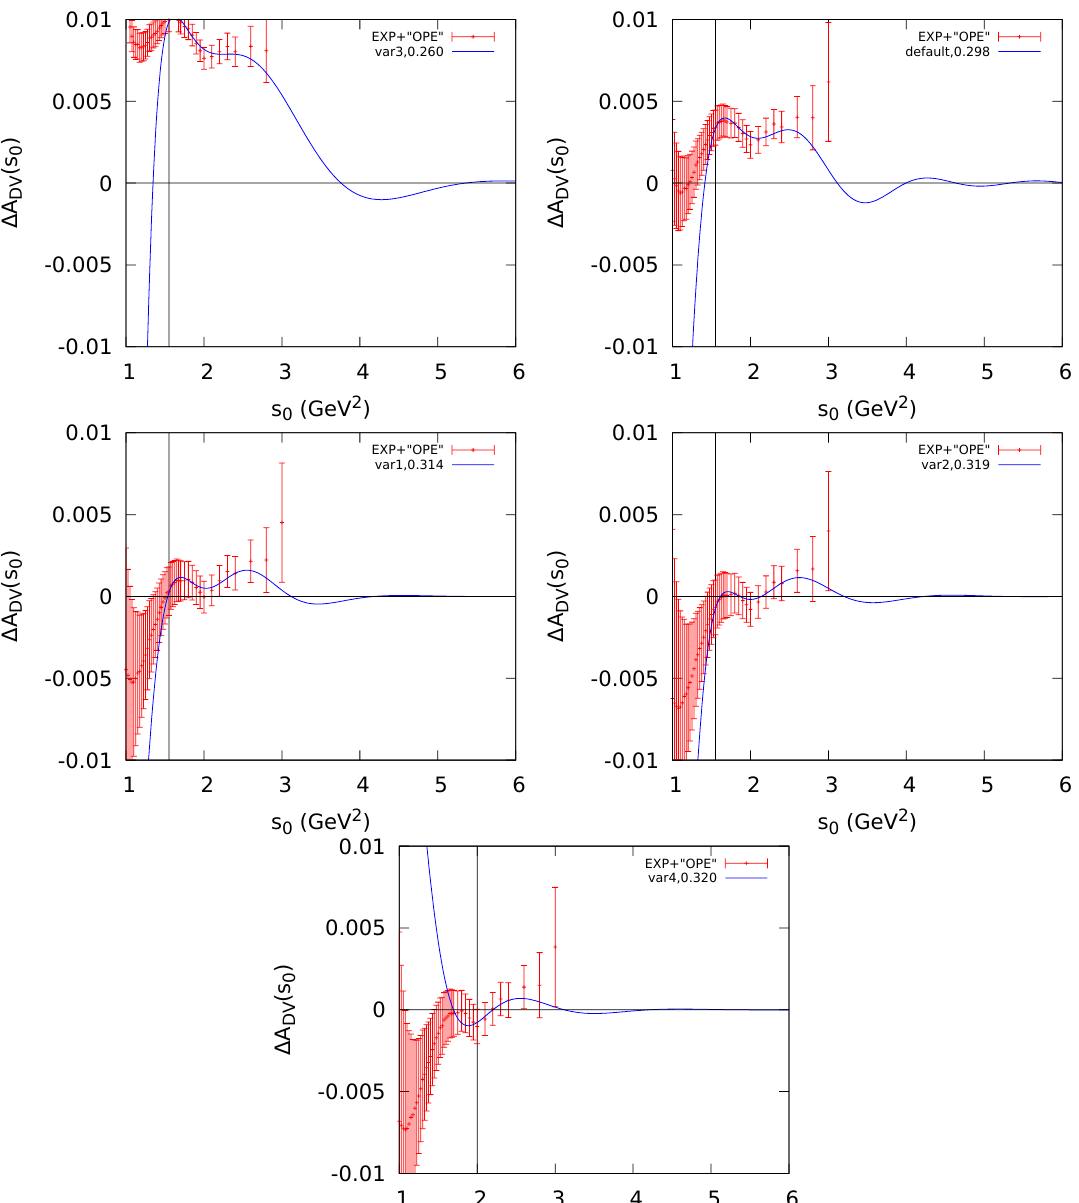
( s ) , obtained with the different ansatz variations, ordered 0 V + A